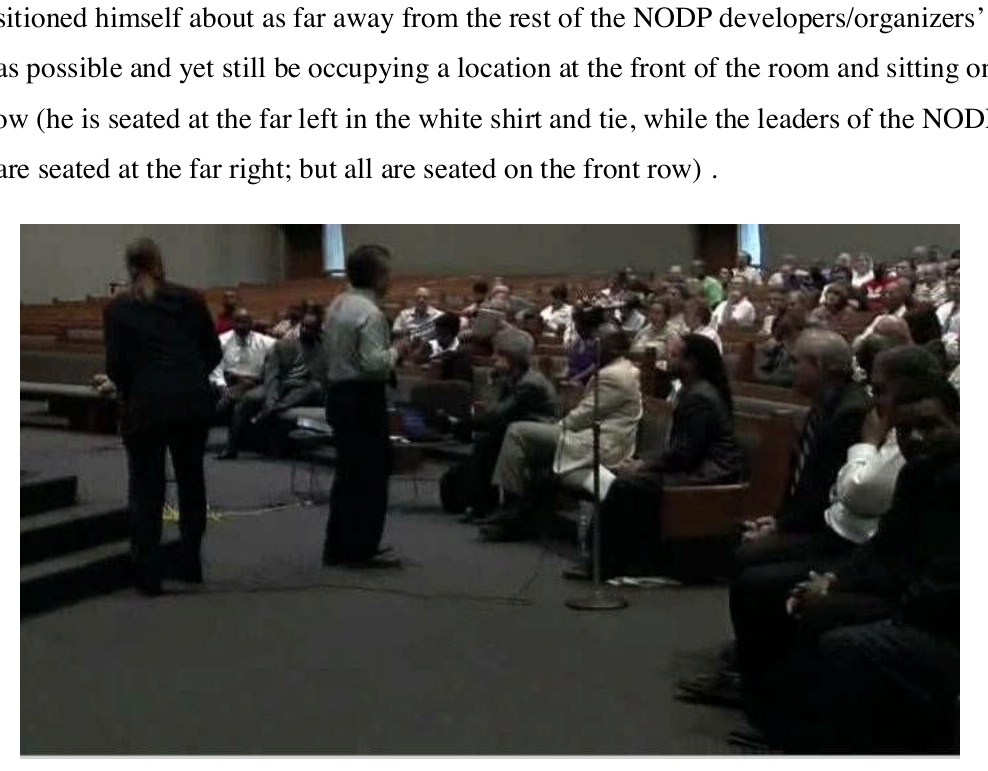
Figure 4: Dick Davis sitting at far left front row at great distance from NODP